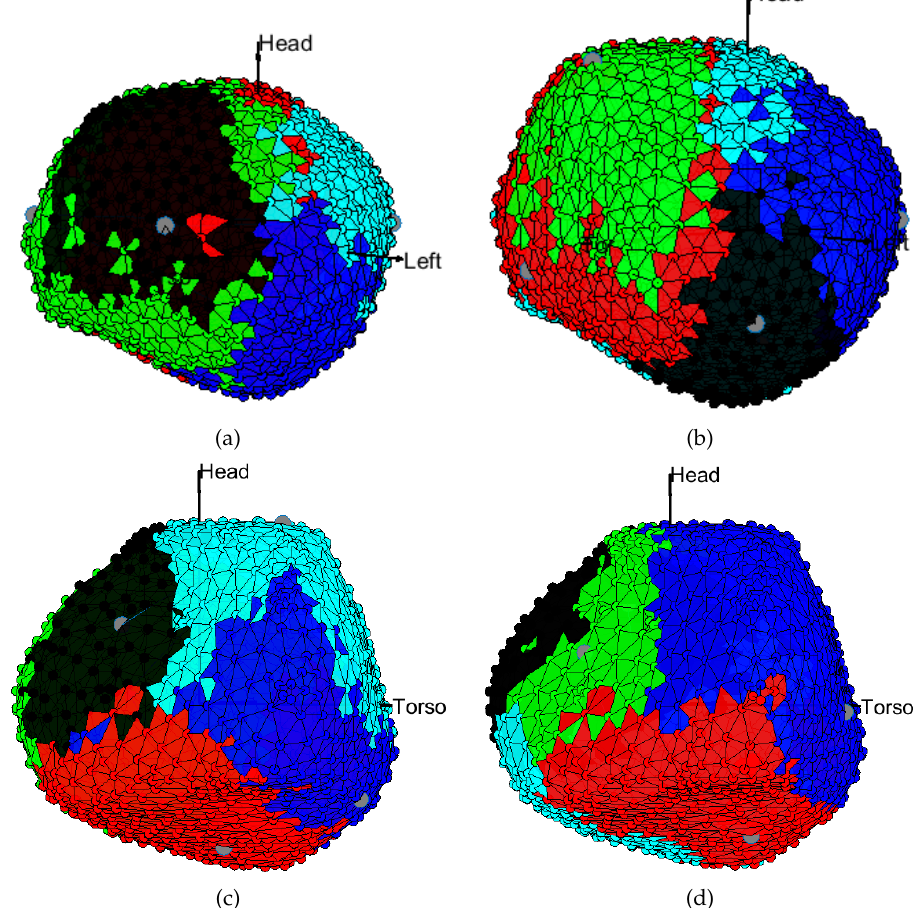
Figure 5. Bipolar EGMs in the presence of infarction. The distances used in the K -means algorithm with K = 5 correspond to: ( a ) L 1 distance; ( b ) Euclidean distance; ( c ) cosine distance; ( d ) correlation